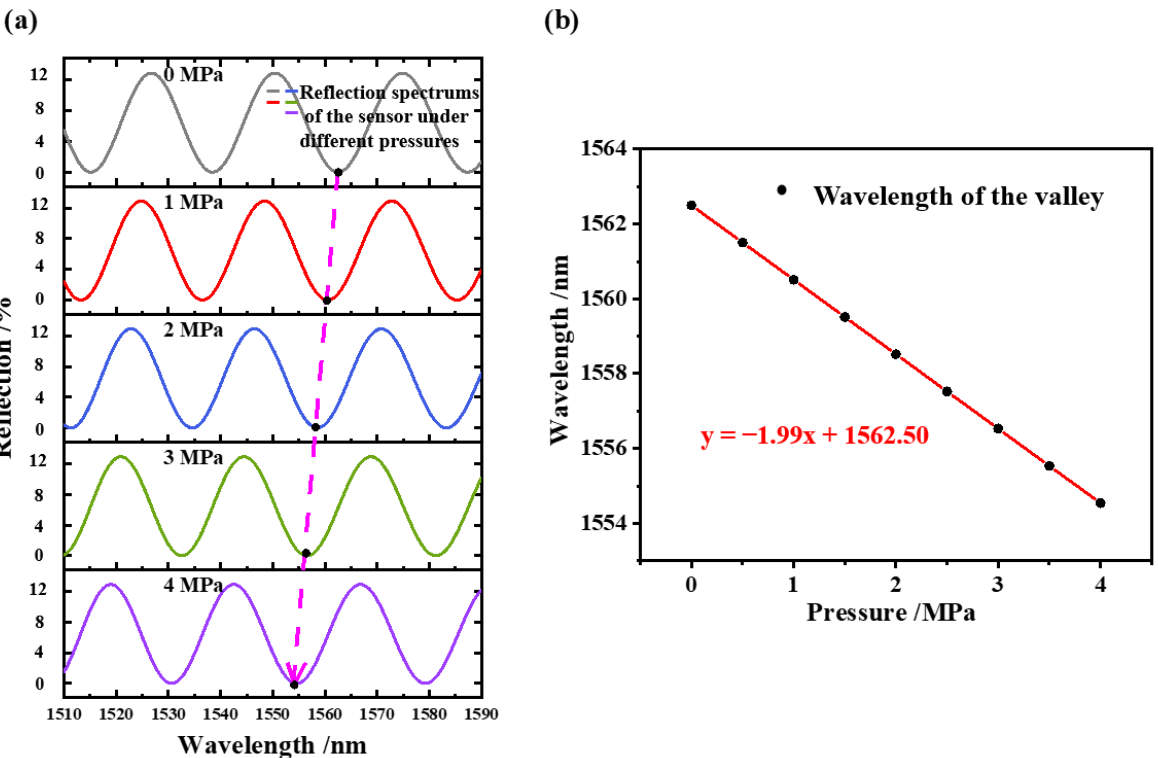
Figure 3. The simulated reflective spectrum of the sensor under different pressures. ( a ) The blue- shifted tendency when increasing the pressure from 0 to 4 MPa; ( b ) dip wavelength variation with increasing pressure.